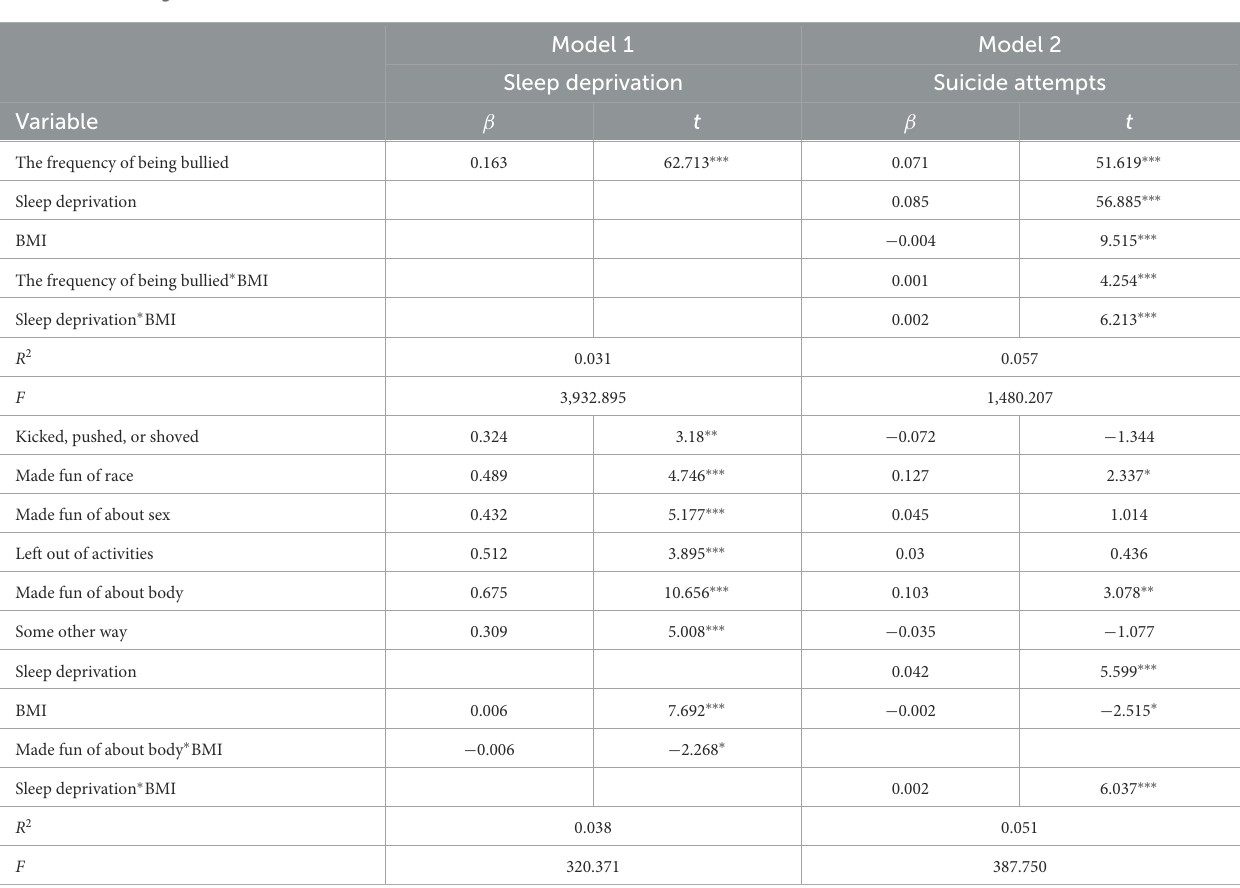
TABLE 3 Moderating effect of BMI ( n =